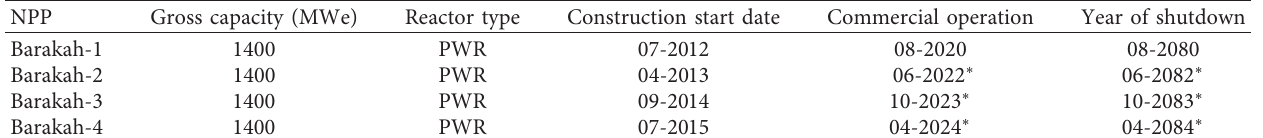
Figure 1: Summary classifications of international models applied, in percentages. Table 1: Overview of Barakah site reactors and expected shutdown dates [40].